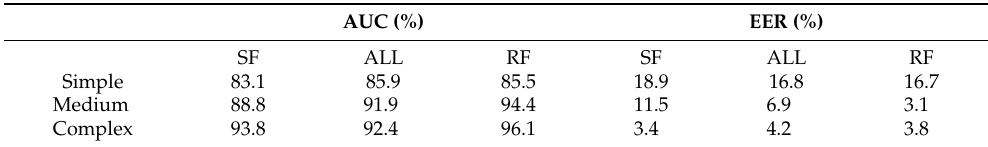
Table 2. AUC and EER for different signature